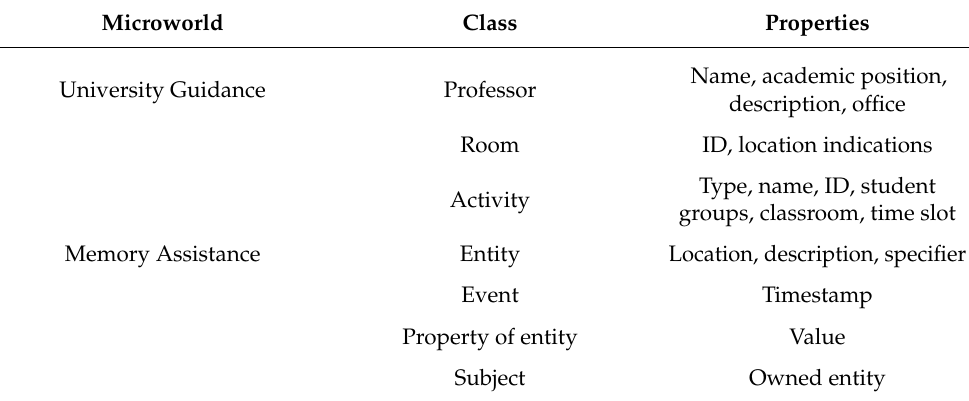
Table 1. Knowledge base classes and properties.